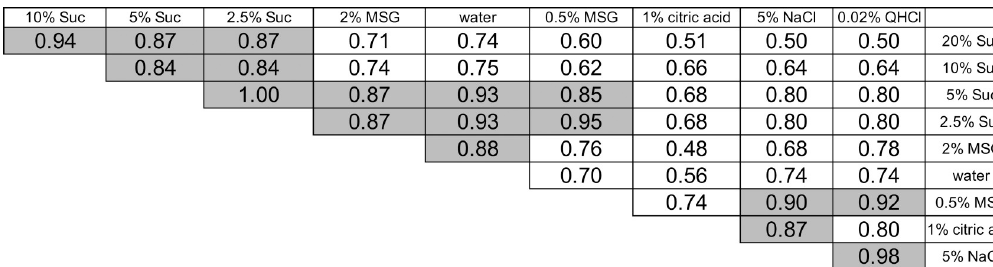
Fig 3. Spearman’s correlation coefficient matrix of the hedonic profiles for 10 stimuli. Correlations were calculated between pairs of stimuli based on the mean scores of eight emotions shown in Fig 1. The taste stimuli were arranged in the order of the most positive to most negative perceived hedonic ratings from left to right and from top to bottom. Coefficients shaded are statistically highly significant ( P < 0.01).